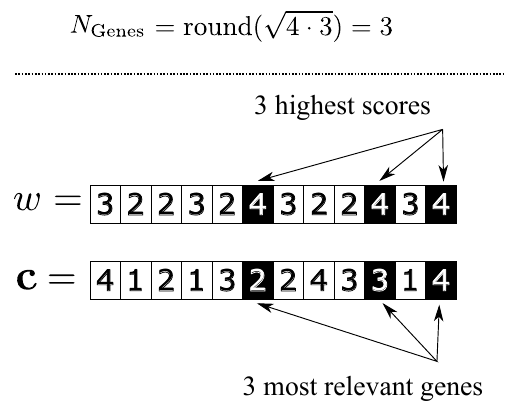
Figure 3. Determination of the most significant genes of a representative